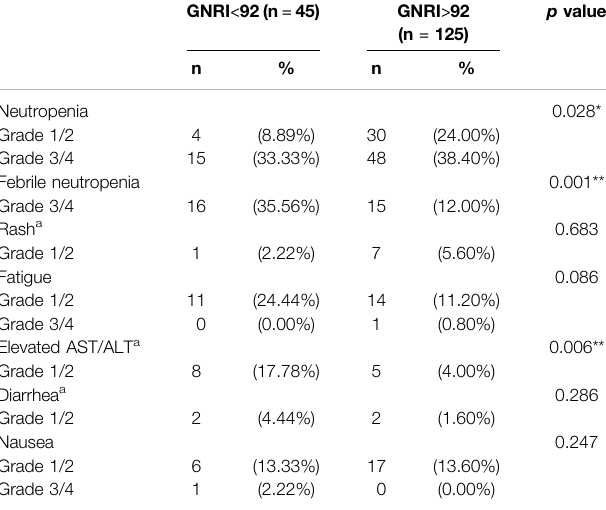
TABLE 3 | Adverse